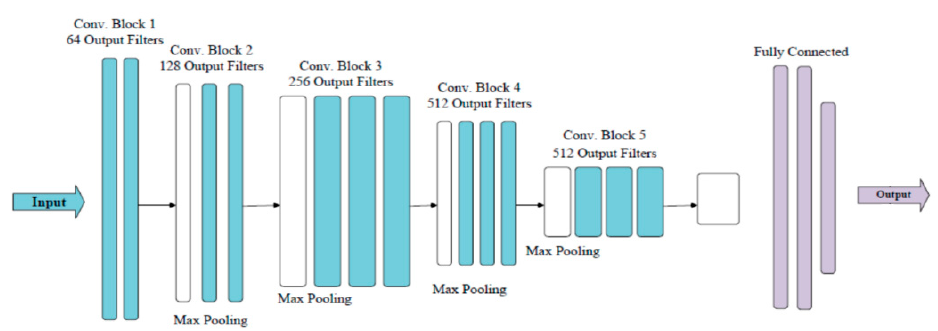
Figure 3. The structure of a VGG model (derived from [39]).